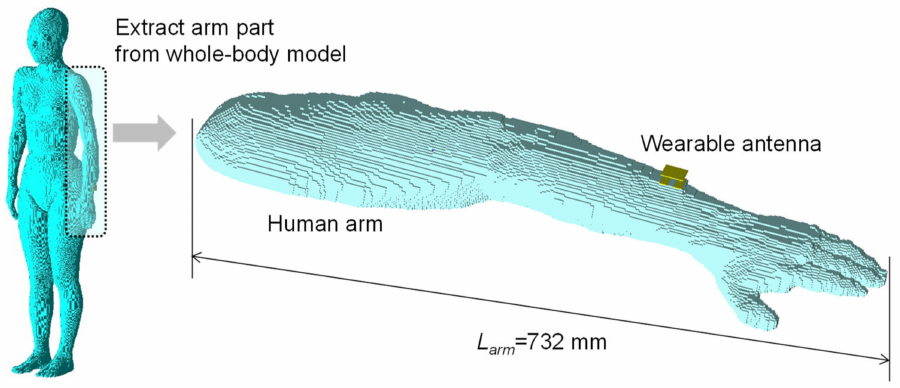
Figure 2. Realistic human arm